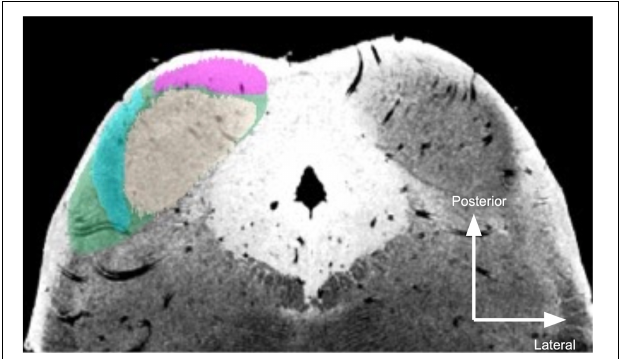
FIGURE 1 | Segmentation of post mortem inferior colliculus and its major subdivisions. Neutral gray, central nucleus (ICc); magenta, dorsal nucleus (ICd); turquoise, external nucleus (ICx); green, overall inferior colliculus (IC). The right IC is unsegmented to show MR contrast. Segmentations were performed manually on the 50 µ m isotropic T2*-weighted anatomical dataset and transformed to dMRI space (200 µ m isotropic).